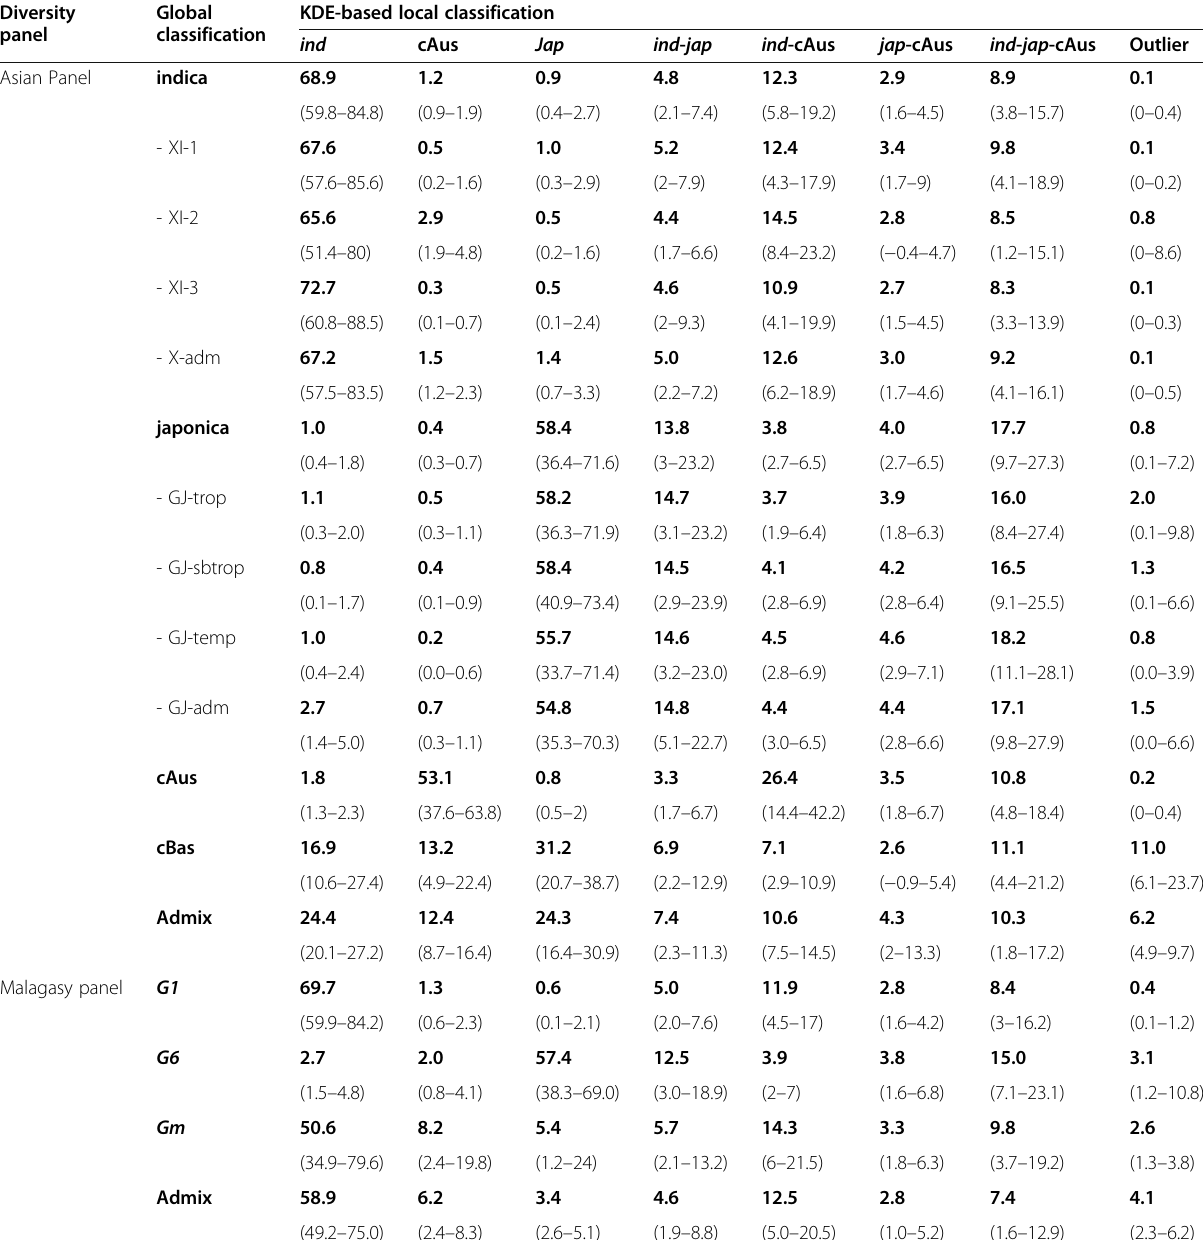
Table 2 Mean shares (%) of the eight categories of haplotypes identified by the KDE-based local classification, in each population and subpopulation of the Asian and Malagasy diversity panels Diversity